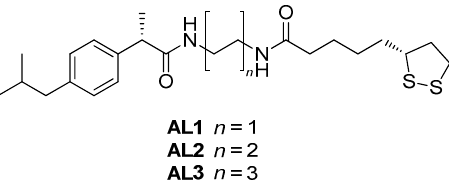
Figure 1. Chemical structures of AL1 – 3 .